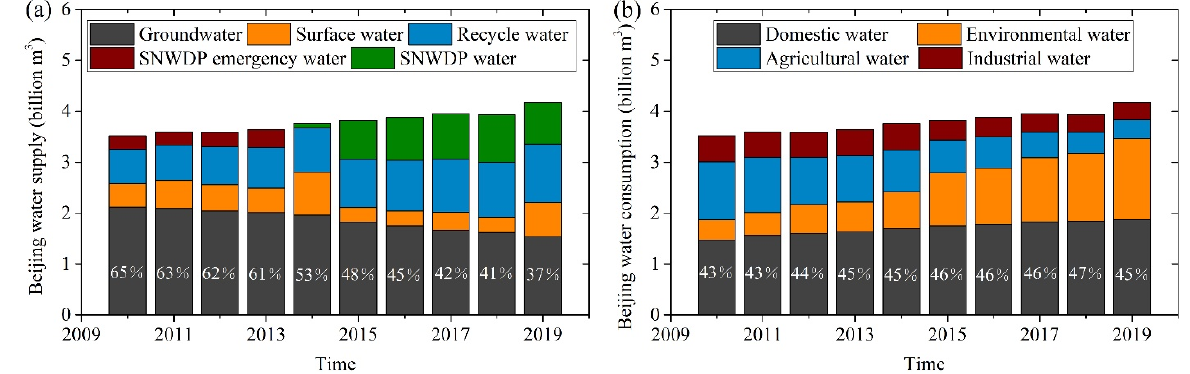
Figure 6. ( a ) The structure of total water supply. ( b ) The structure of total water consumption.